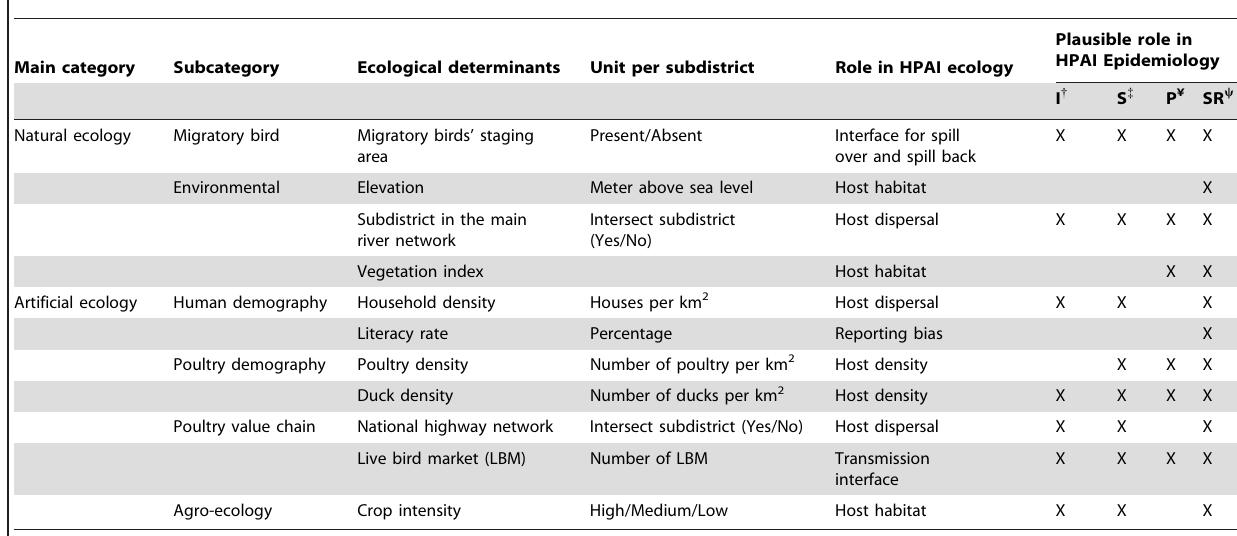
Table 1. Highly pathogenic avian influenza in Bangladesh, 2007–2008; classification and description of the independent variables included in the regression